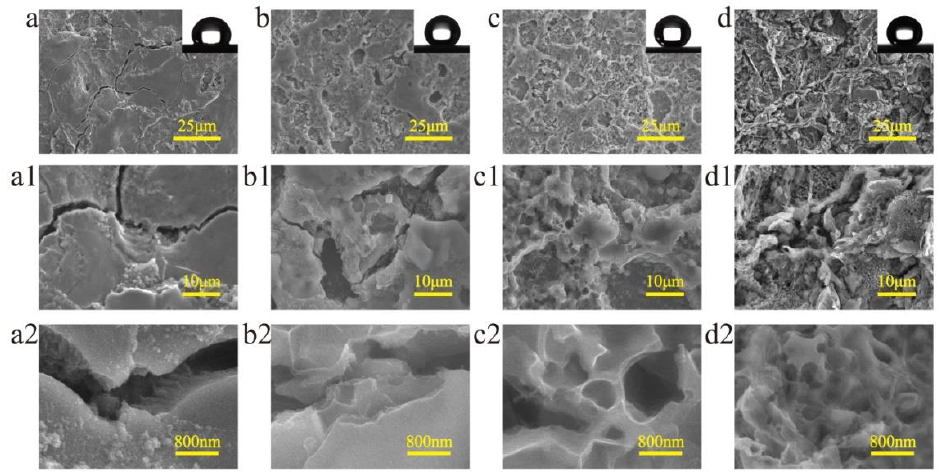
Figure 3. SEM images of the surface morphology of titanium machined by EDM and under different ECE times of ( a ) 0 s ( b ) 10 s, ( c ) 20 s, and ( d ) 30 s. ( a1 – d2 ) is the magnification of (a–d), respectively.